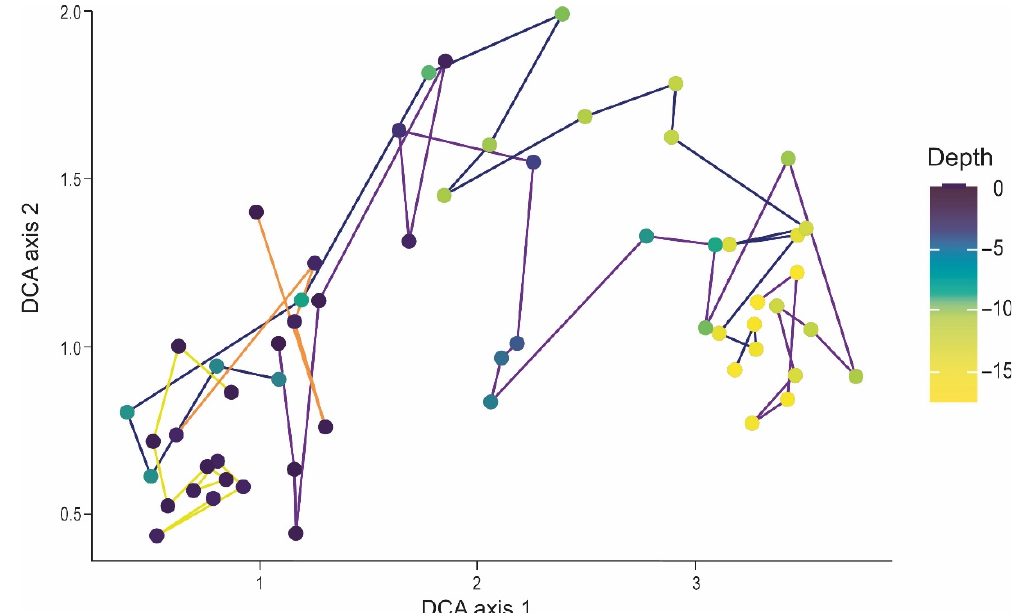
Figure 4. DCA diagram of vegetation plots. Only plots belonging to A4 and A8 are presented for clarity (A4 lines in yellow and orange shades, A8 lines in blue and purple shades). Plots belonging to the same transect are connected. Each doline has two transects, from the center to the north and from the center to the south. The difference between shallow (A4) and deep (A8) dolines is evident.